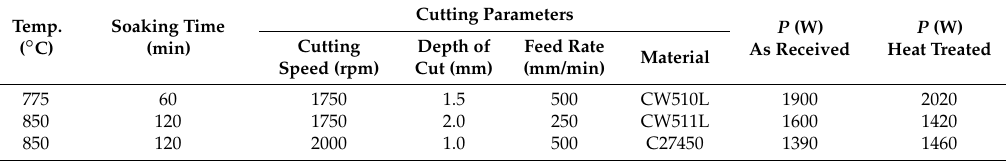
Table 6. Power consumption results of lead-free brasses after the selected heat treatment processes. Temp. ( ◦